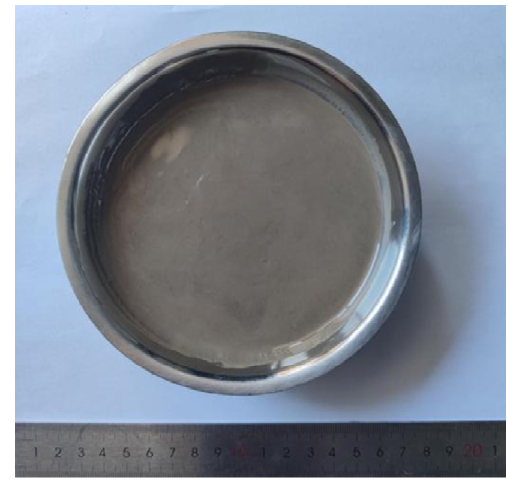
Figure 1. Form of test construction slurry.